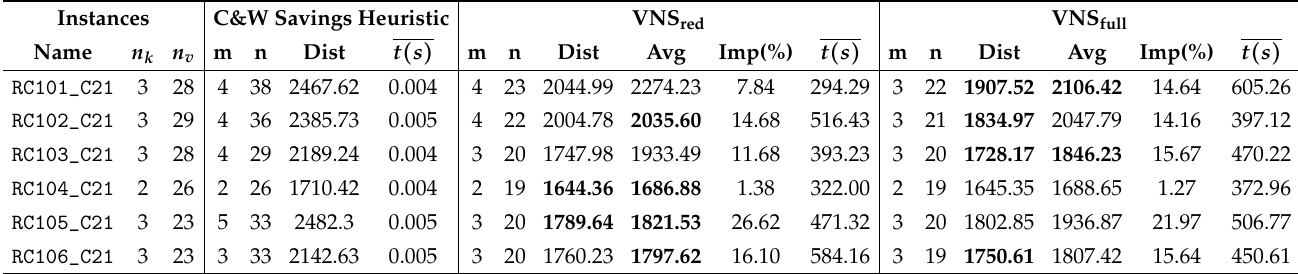
Table 10. Computational results for large-sized random-clustered